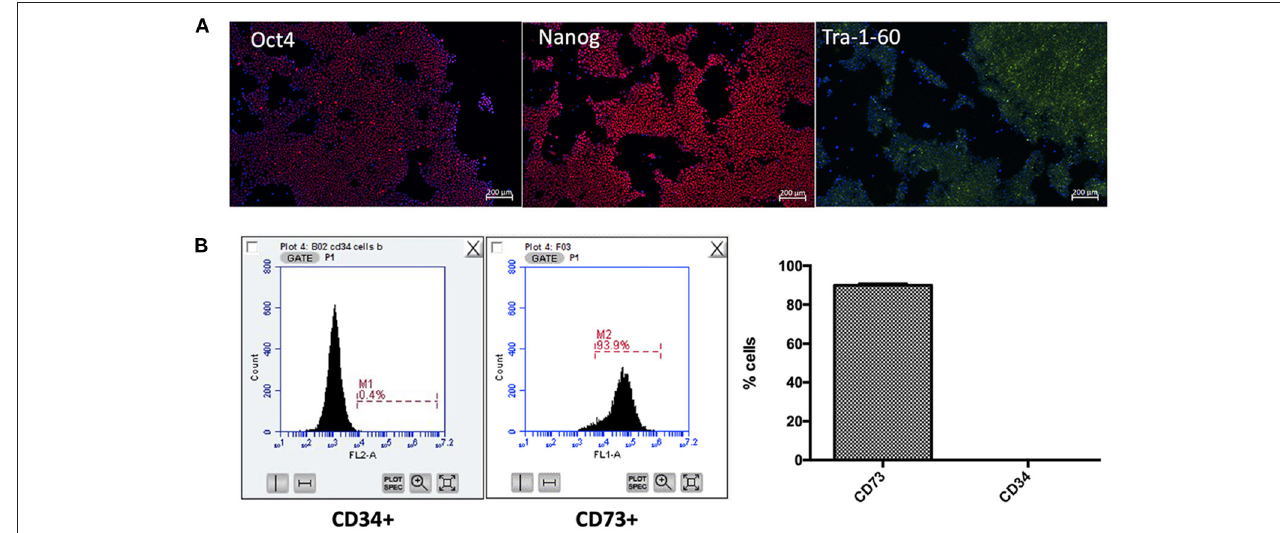
FIGURE 1 | Characterization of iPSC-UkB-Ctrl-XX and generation of iMSC. Immunocytochemistry, (A) confirms pluripotency of cell line by expression of pluripotent markers Oct4, Nanog and Tra-1-60. (B) FACS sorting for CD73 and CD34 confirms that no cells are expressing hematopoietic stem cell marker CD34 and are positive for mesenchymal stem cell marker CD73.